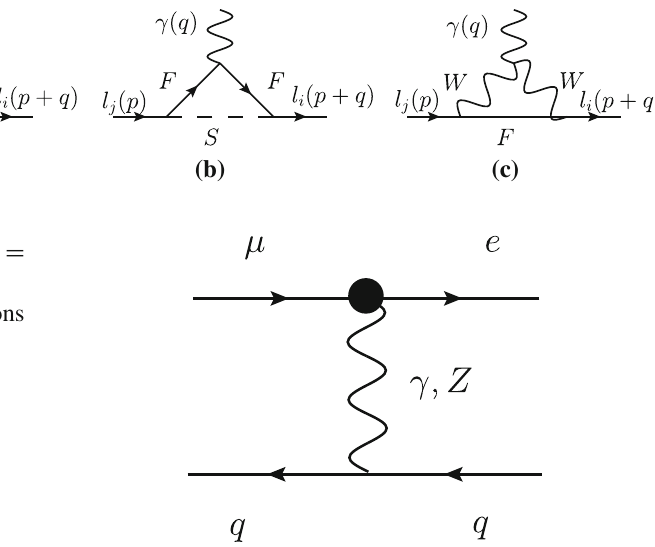
Fig. 2 The penguin type diagrams for the μ − e conversion processes at the quark